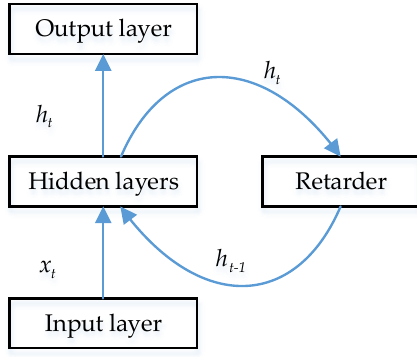
Figure 7. Structure of basic RNN.